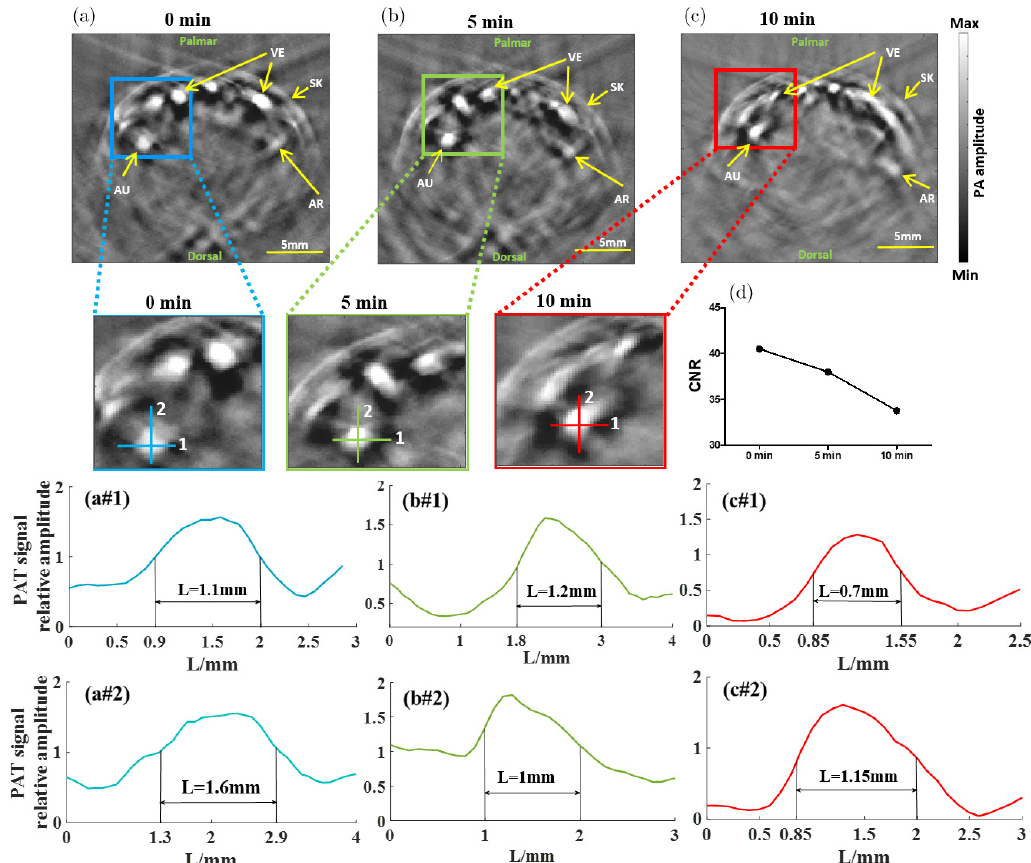
Fig. 5. PAT images of the ¯nger joint using water immersion at 0min (a), 5 min (b) and 10 min (c). (d) CNRs of the images shown in (a), (b) and (c). PA signal pro¯les and calculated FWHM along the cutting lines 1 and 2 for the image shown in (a) (a1 and a2), in (b) (b1 and b2) and in (c) (c1 and c2).